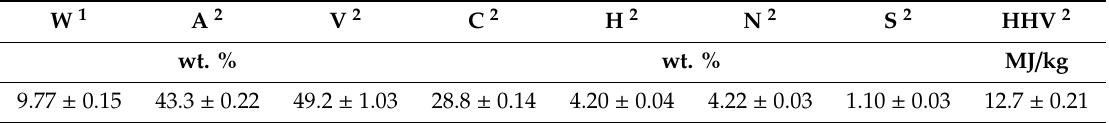
Table 1. Physical and chemical properties of sewage